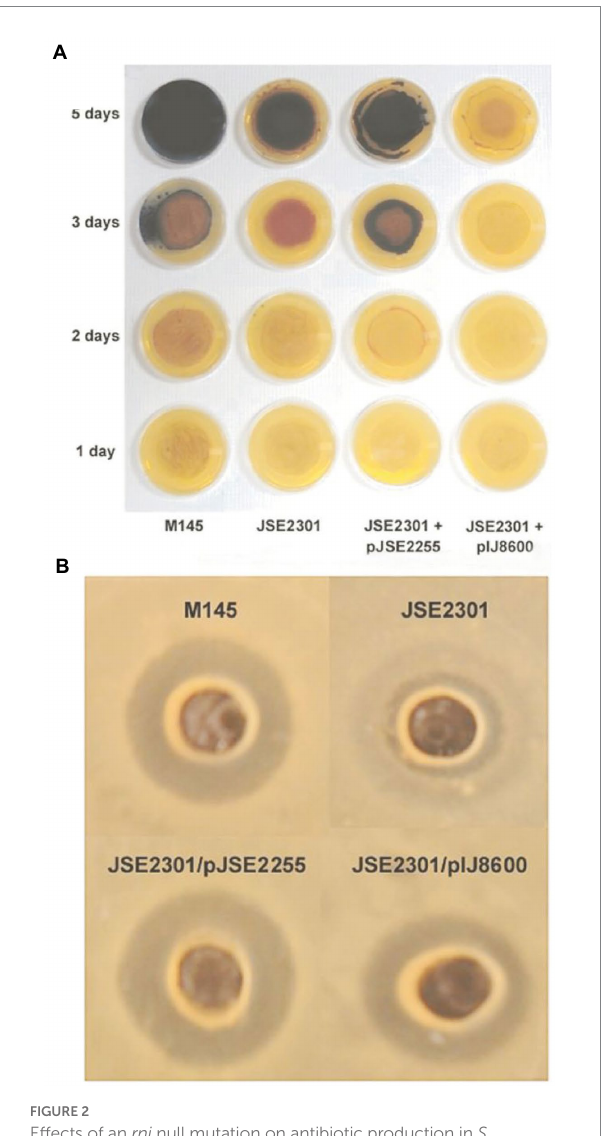
FIGURE 2 Effects of an rnj null mutation on antibiotic production in S. coelicolor . The top panel (A) shows the temporal progress of act and red production in the parental (M145) and mutant (JSE2301) strains cultured on solid medium that supports antibiotic biosynthesis. pJSE2255 is a plasmid containing the wild type RNase J gene cloned into the streptomycete expression vector, pIJ8600. In the rnj null mutant, act production is suppressed while red is overproduced. The bottom panel (B) shows the levels of cda production in the wild type and parental S. coelicolor strains. The figure shows zones of inhibition produced by cda action against a cda-sensitive bacterial strain, B. subtilis BG267. Reprinted with permission from Pei et al.